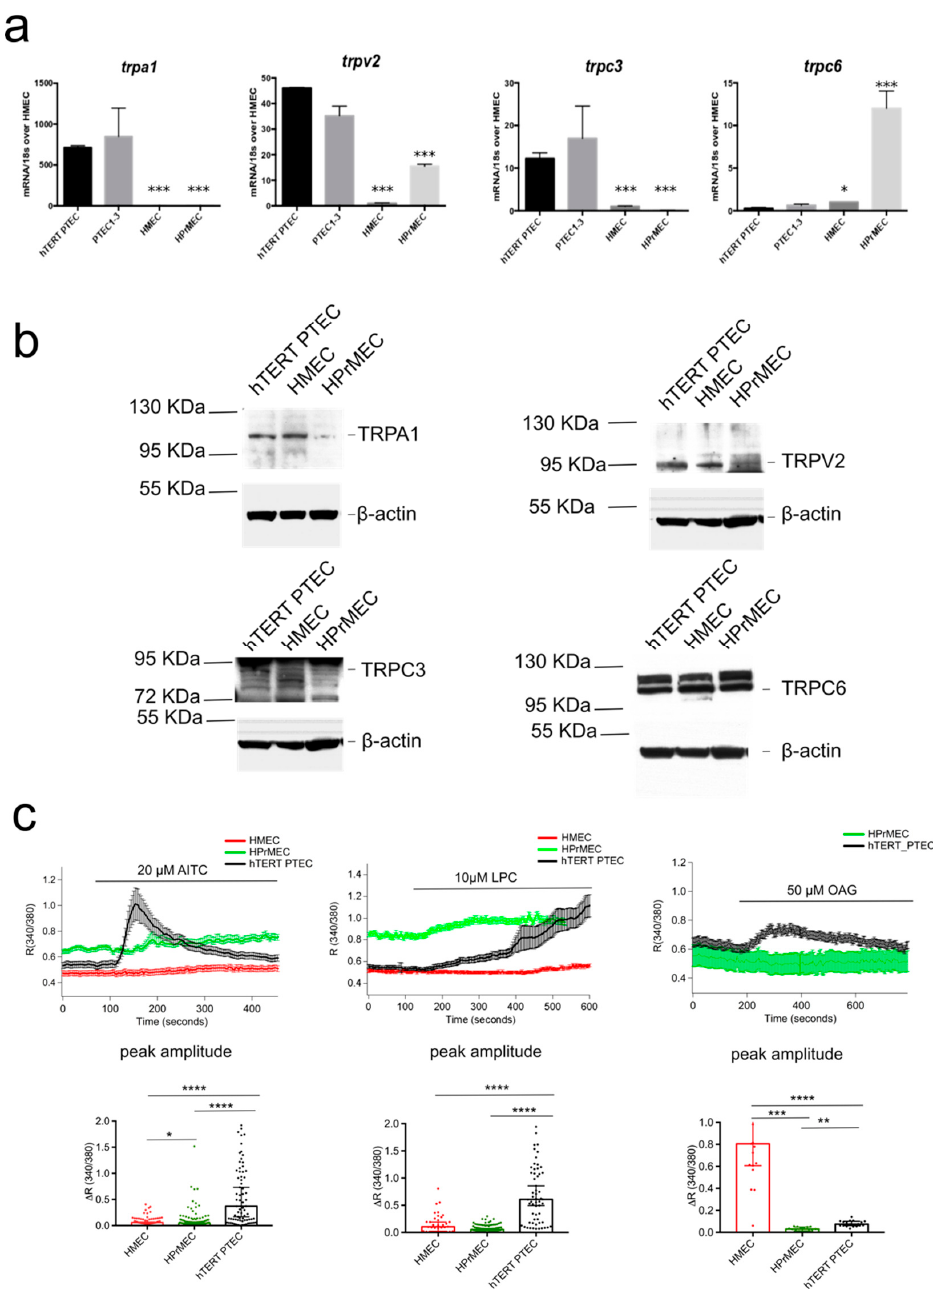
Figure 4. hTERT PTEC validation as cellular model for TEC studies. ( a ) Real-time qPCR analysis validating equal amount of mRNA expression if trpa1 , trpv2 , trpc3 and trpc6 in hTERT PTEC compared to PTEC1-3, as well as deregulated expression compared to HMEC and HPrMEC. Values are expressed as the mean ΔΔ CT values ± SEM of three independent experiments. ( b ) Representative immunoblots blots ( n = 3) showing similar TRPA1, TRPV2 and TRPC3, and TRPC6 expression in hTERT PTEC compared to PTEC1, 2 and 3. Β -actin was used as a loading control. ( c ) Ca 2+ - imaging traces in response to TRPA1, TRPV2 and TRPC3 agonists respectively 20 µM AITC), 10 µM LPC and 50 µM OAG in HMEC (red), HPrMEC (green) and hTERT PTEC (black). Traces represents mean ± SEM of all cells in the recorded field of one representative experiment. Lower panel: histogram showing peak amplitude of TRP agonist-mediated Ca 2+ responses (median ± 95% CI of different cells in the field from at least three independent experiments). Statistical significance *: p -value < 0.05, **: p -value < 0.005 and ****: p -value < 0.0001 (Kruskal-Wallis test.).